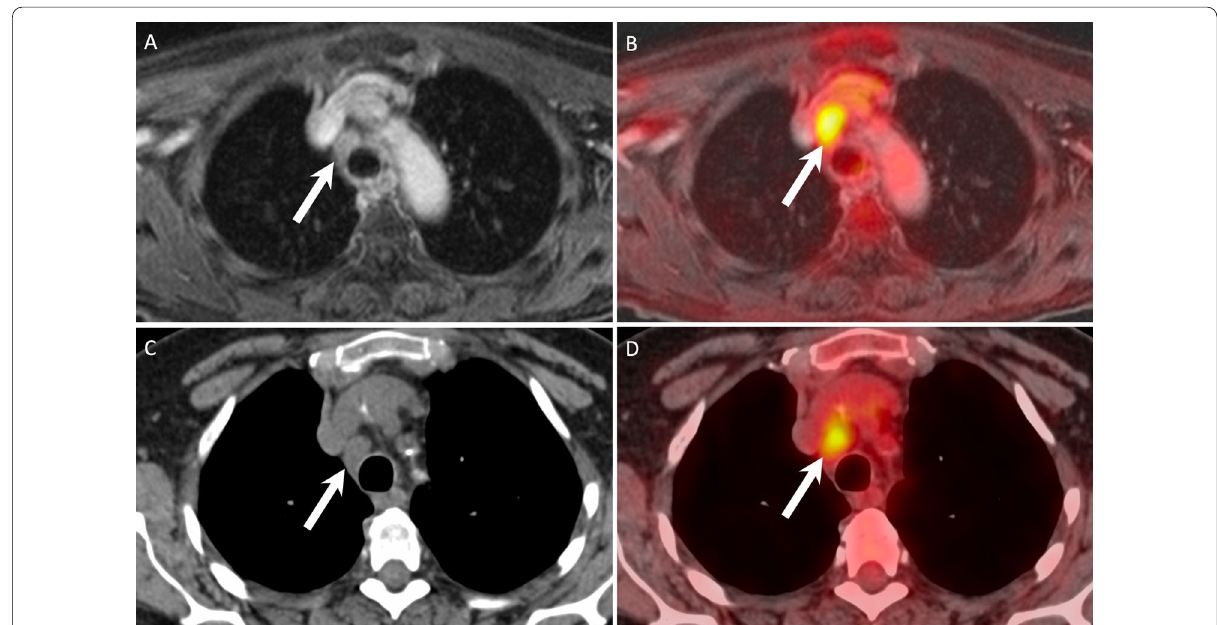
Fig. 6 False positive PET/MRI ( A, B ) and PET/CT ( C, D ) in a 63-year-old female imaged for follow-up of a SCC of the larynx (T3N1) treated with radiochemotherapy. Both PET/MRI and PET/CT were rated as positive for distant mediastinal lymph node metastases. An enlarged mediastinal lymph node (arrows) shows a combination of high focal [ 18 F]FDG uptake (SUVmax on PET/MRI heterogeneous contrast enhancement on the contrast-enhanced fat-saturated MR image. On the corresponding CT image, due to the absence of contrast enhancement, only lymph node enlargement was present (13 a score of 4 on PET/CT. However, mediastinoscopy with biopsy revealed